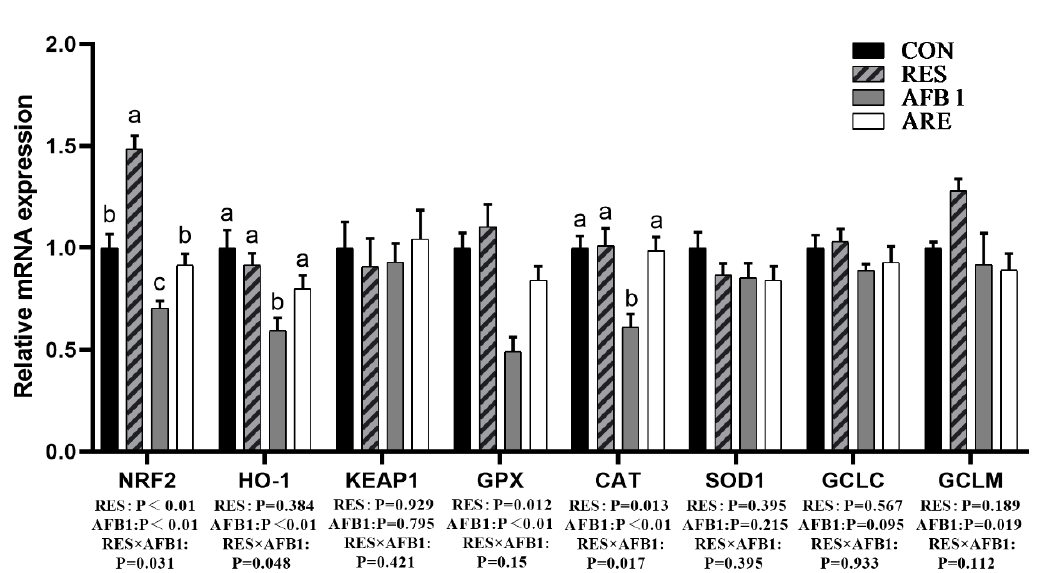
Figure 5. The e ff ect of resveratrol on the hepatic antioxidant parameters in AFB 1 -challenged mice. qPCR analysis of hepatic antioxidant mRNA expression in di ff erent groups ( n = 6 / group). All data were analyzed using two-way ANOVA and Duncan’s post hoc testing, where appropriate. Data are represented as mean ± SEM. a–c Mean values within a line with di ff erent superscript letters were significantly di ff erent ( p < 0.05).